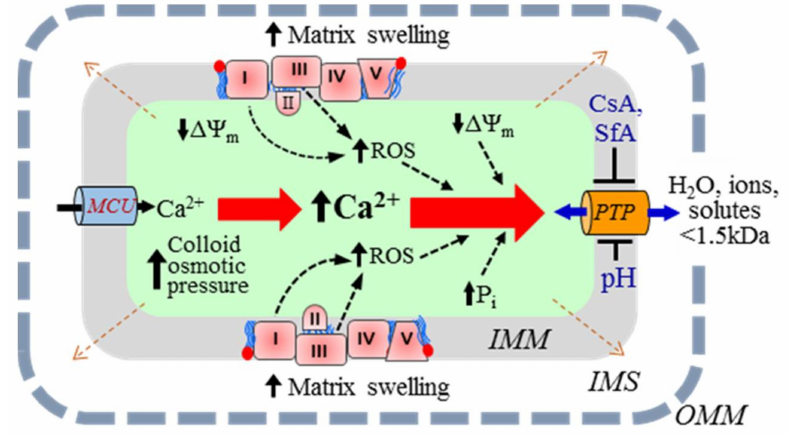
Figure 1. The mechanism of Ca 2+ -induced swelling of mitochondria. (See text for